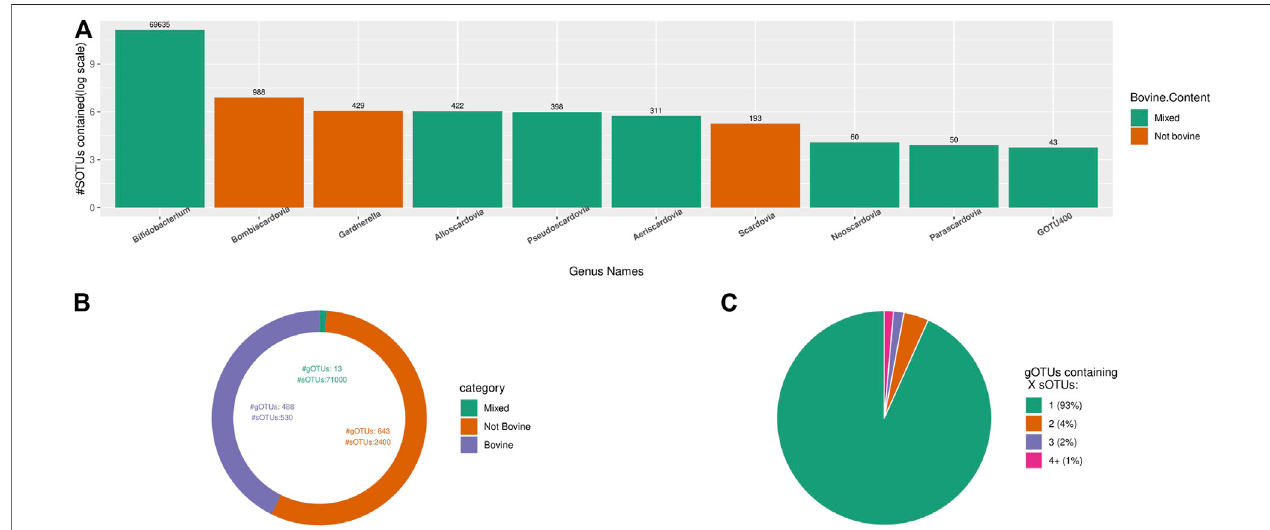
FIGURE8| Overviewoftheenvironmentaloriginsofthe Bi fi dobacteriaceae sequencesgroupedingOTUs. (A) Rankorderof10mostdiversegOTUs,differentiated bytheoriginsoftheirconstituentsOTUs. Bi fi dobacterium isbyfarthemostdiversegenusofthisfamily. (B) Highnichespeci fi cityof Bi fi dobacteriaceae gOTUscontained within the bovine samples. (C) Pie chart indicating the size of gOTUs created by TIC from all available sequences classi fi ed as belonging to the Bi fi dobacteriaceae family extracted from IMNGS.